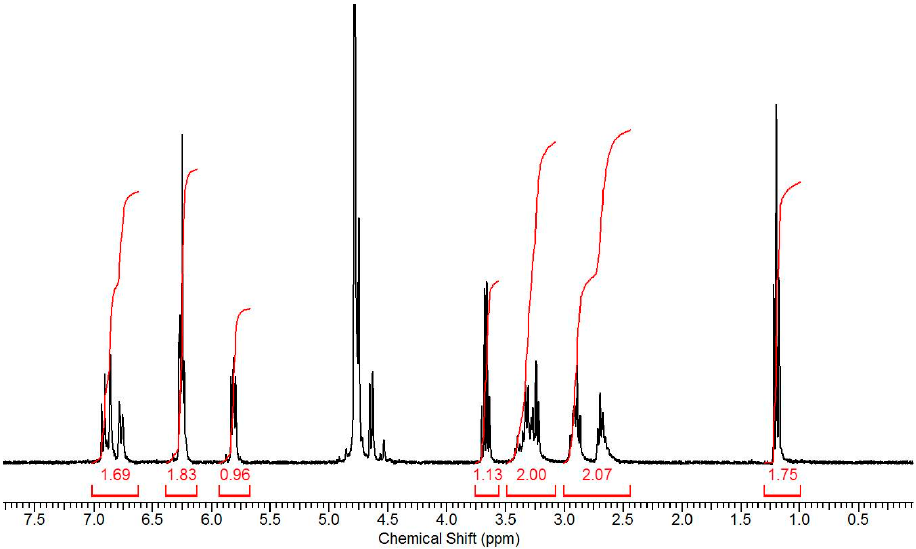
Figure 3. 1 H NMR spectra of the crosslinker (dopamine-N ′ N ′ -methylene-bis-acrylamide (MBA)).